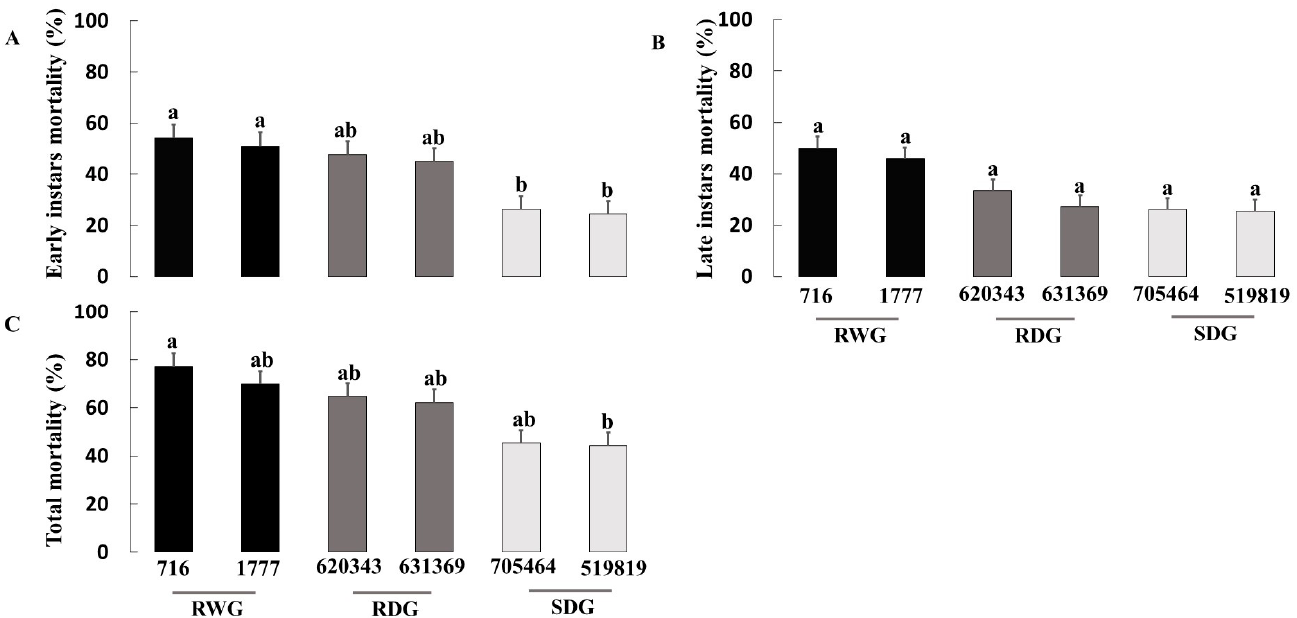
Figure 4. Mean mortality (% ± SE) of early instars ( A ), late instars ( B ), and total mortality to adulthood ( C ) of Orius laevigatus on six tomato genotypes with different levels of resistance to Phthorimaea absoluta . Bars with shared letters within the panel do not differ significantly (one-way ANOVA; Tukey test; p ≤ 0.05). RWG = resistant wild genotypes; RDG = resistant domesticated genotypes; and SDG = susceptible domesticated genotypes.